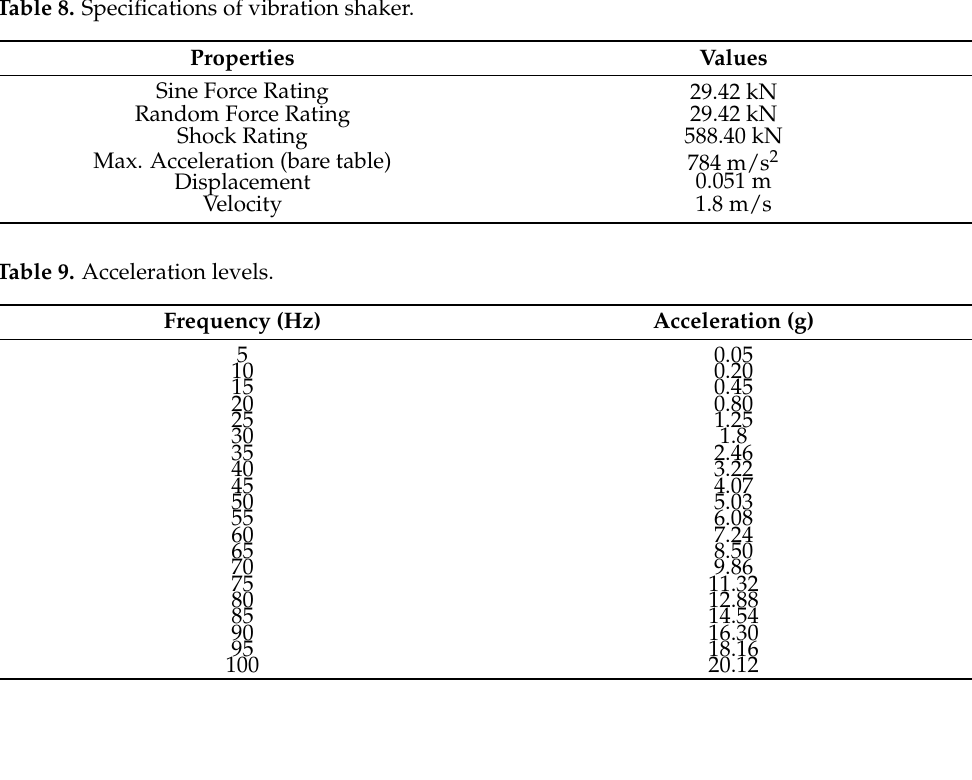
Table 8. Specifications of vibration shaker.